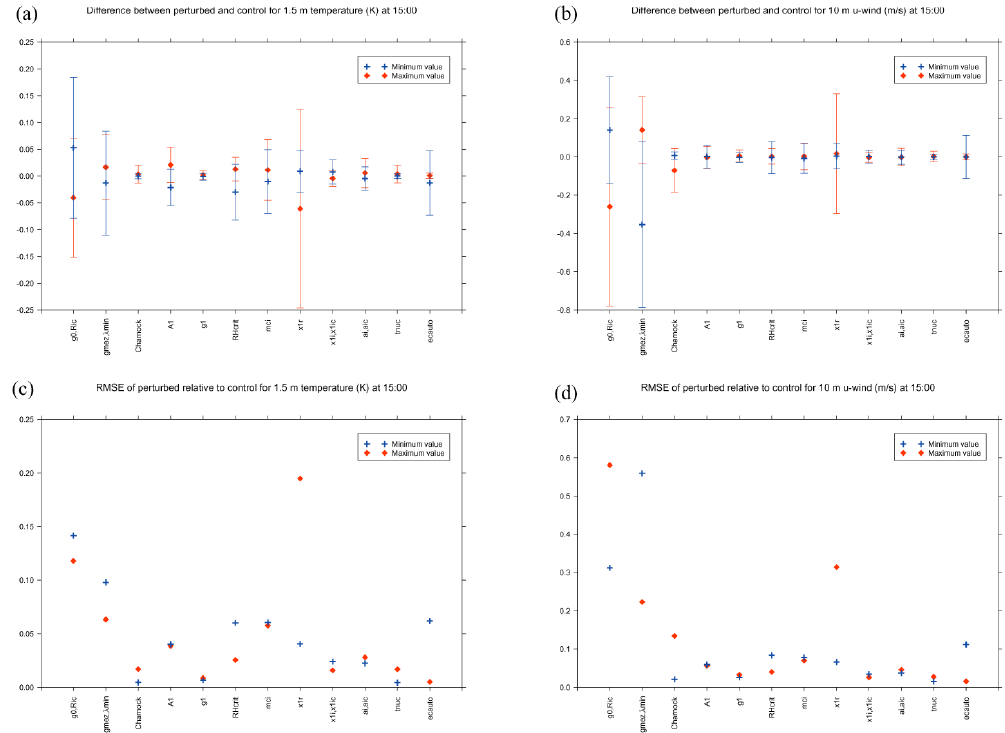
Fig. 7. Sensitivities of the forecasts at T + 3 (15:00UTC) to perturbing parameters to their maximum and minimum values. Top row: difference between perturbed and control forecast at each point, averaged over the domain. Error bars show the standard deviation of the differences. Bottom row: RMS difference between the perturbed and control forecast at each point, averaged over the domain. Left column: 1.5m temperature. Right column: u component of 10m